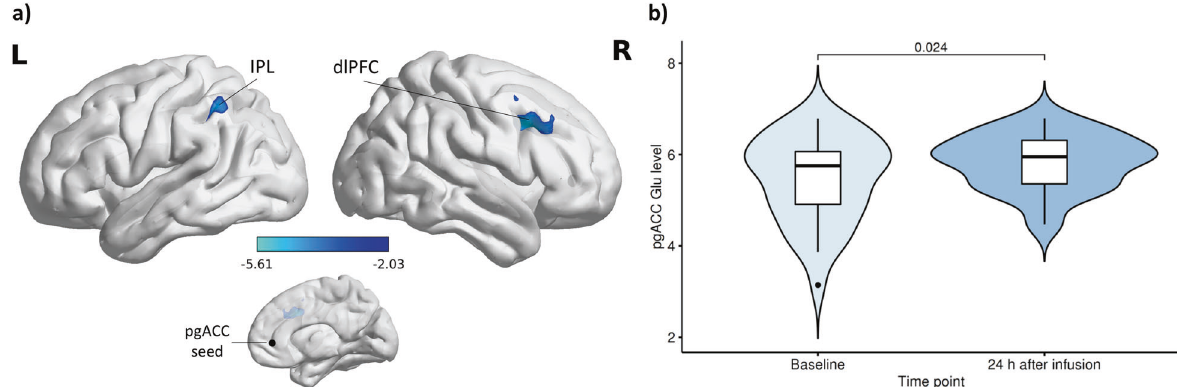
Fig. 4 PgACC resting-state functional connectivity and glutamate levels 24 h after S-ketamine infusion. PgACC rsFC decreases and Glu level increases 24 h after infusion in the S-ketamine arm. a Left IPL ( x = − 44, y = − 42, z = 38, k = 239, Bonferroni adjusted α = 0.025, = 0.018), dlPFC ( x = 40, y = 16, z = 38, k = 368, Bonferroni adjusted α = 0.025, p = 0.002) and cerebellum ( x = 34, y = − 60, z = − 32, p FWEc FWEc = 0.015, not shown here) (pgACC seed: black sphere). b PgACC Glu levels showed a signi fi cant k = 250, Bonferroni adjusted α = 0.025, p FWEc increase 24 h after infusion compared to baseline in the S-ketamine group ( n = 32, t (31) = − 2.36, Bonferroni adjusted α = 0.025, p = 0.024). dlPFC dorsolateral prefrontal cortex, Glu glutamate, IPL inferior parietal lobe, pgACC pregenual anterior cingulate cortex, rsFC resting-state functional connectivity.